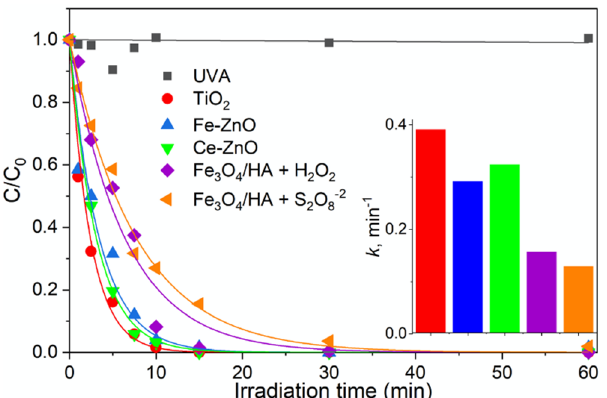
Figure 1. Maprotiline removal in the presence of different oxidation processes under UVA irradiation: photocatalysis using TiO 2 , Fe-ZnO or Ce-ZnO, and heterogeneous photo-Fenton using Fe 3 O 4 /HA for the activation of H 2 O 2 or S 2 O 82 − . The inset compares the kinetic constant